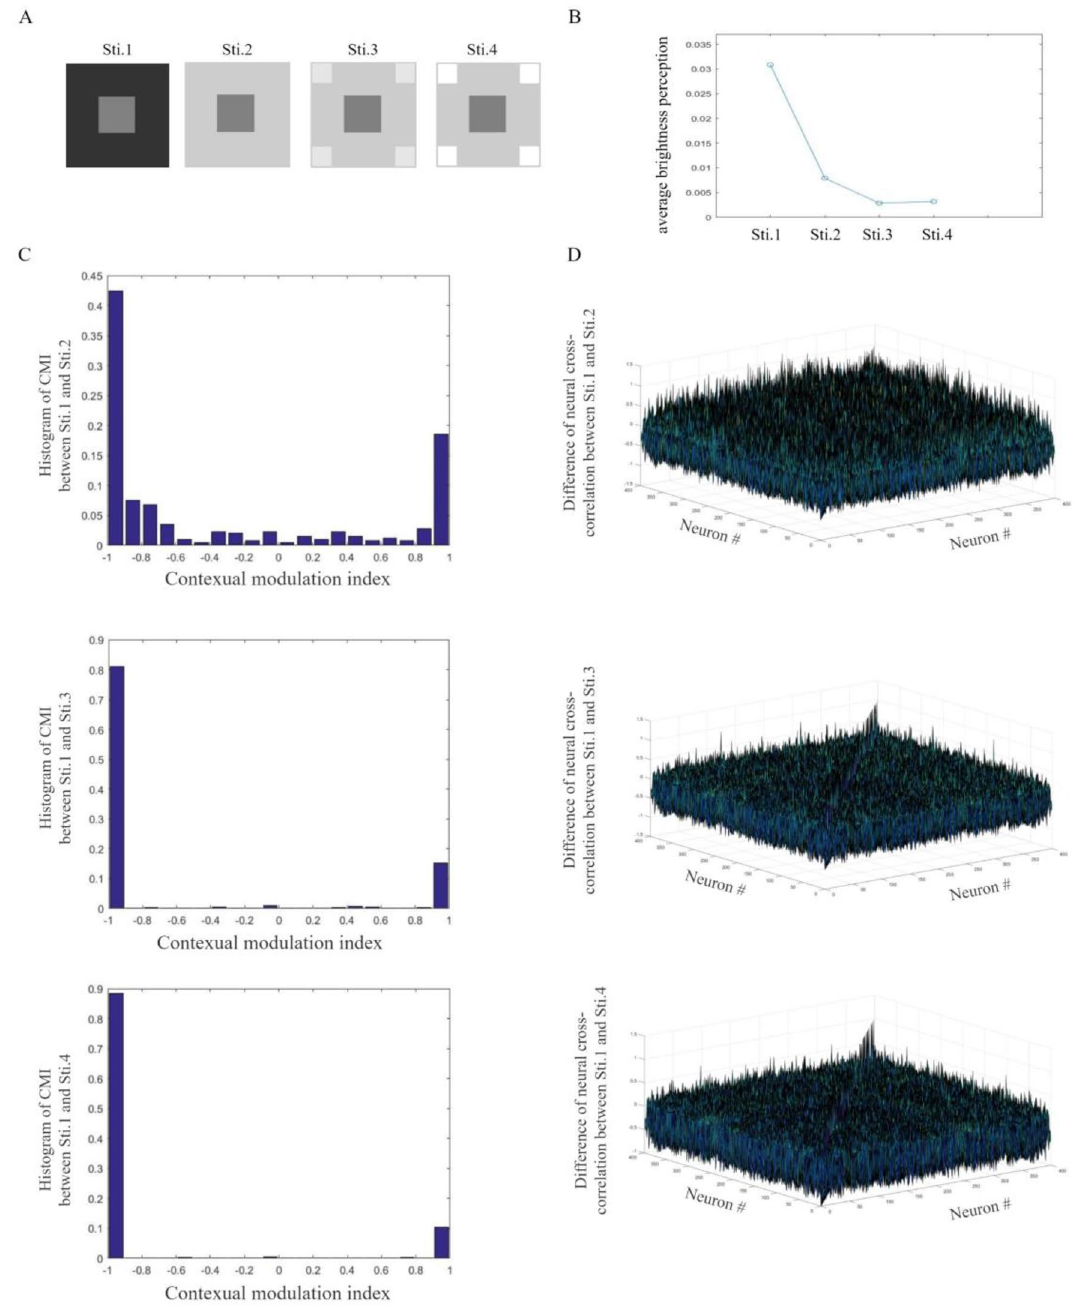
Figure 4. Brightness perception induced by grayscale values of distractors. ( A ) Images used as visual stimuli in our simulations. ( B ) Averaged brightness perception of target squares. For designed stimuli, the target with lighter distractors appears to be darker. ( C ) The histogram of CMIs of excitatory neurons to images. Non-zero CMIs indicate neural responding modifications induced by grayscale values of distractors. For designed stimuli, lighter distractors can induce larger neural responding modulations. ( D ) Differences of excitatory neural responding cross-correlation to stimuli. For each pair of neurons, amplitudes of non-zero differences reflect influences of the varying grayscale value of